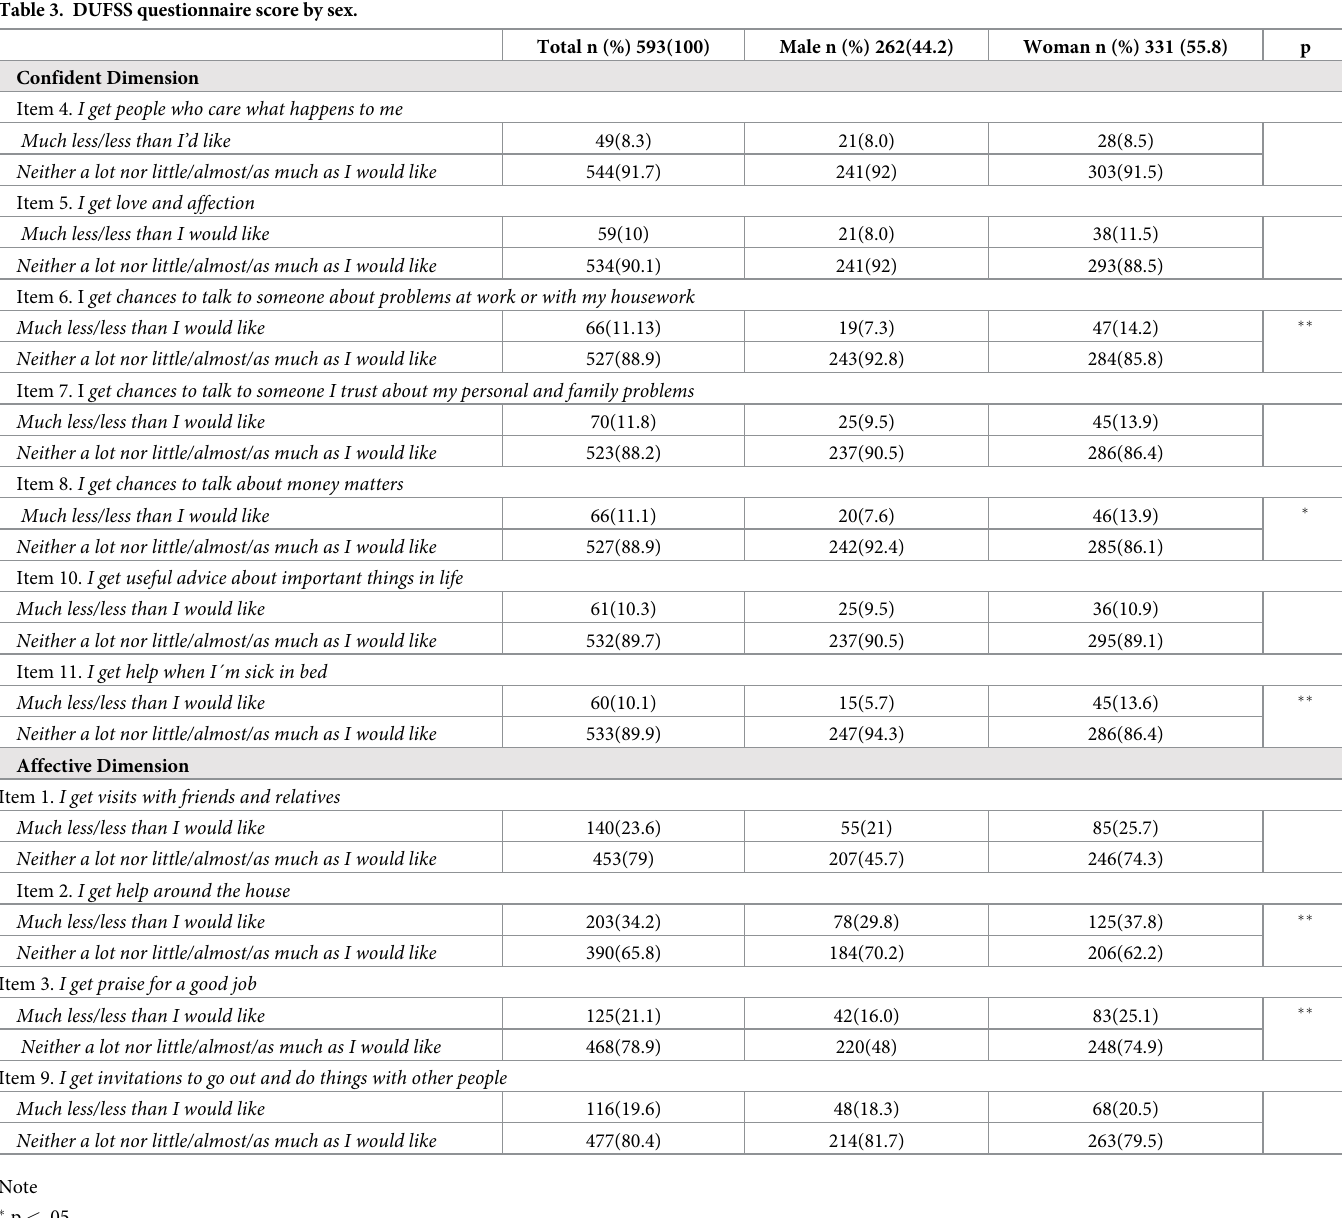
Table 3. DUFSS questionnaire score by